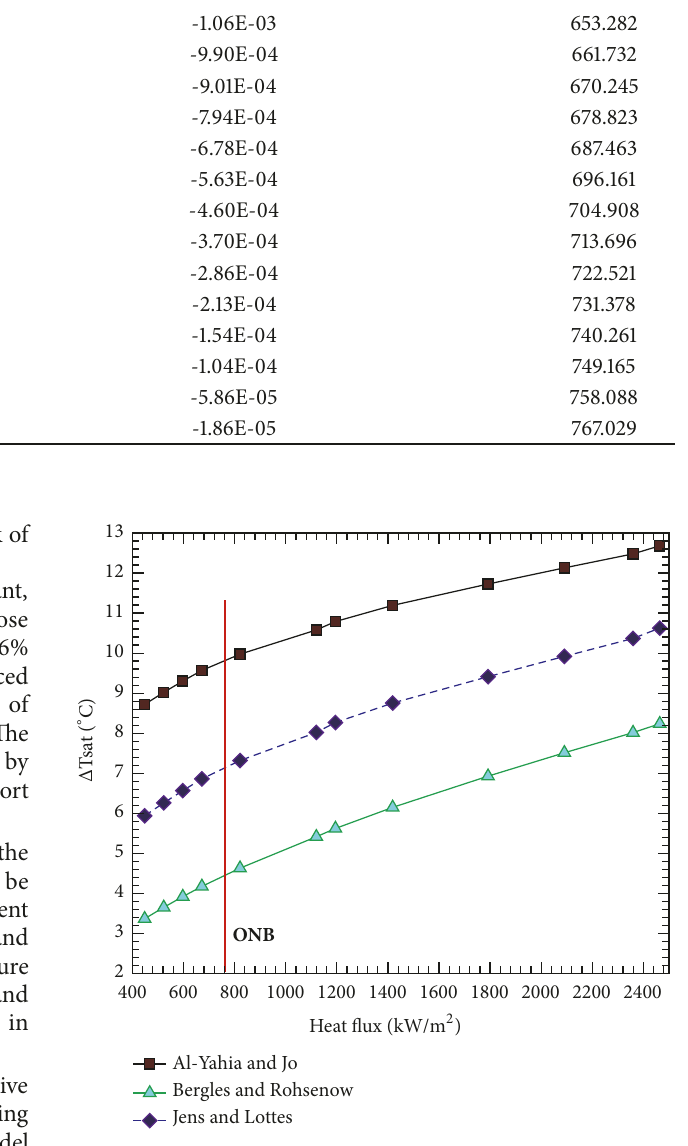
Figure 11: Variationinthewall superheattemperaturewith heatflux for the proposed correlations.